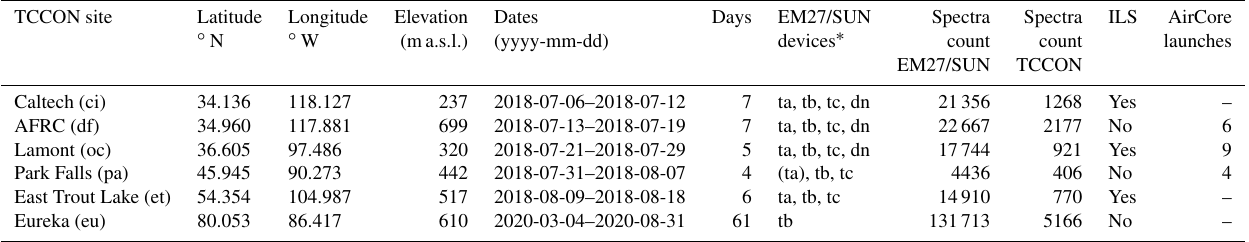
Table 1. This table lists the TCCON site locations and the dates that the EM27/SUN devices were on site, the number of days with successful measurements, the average number of spectra collected by each EM27/SUN, and the total number of spectra collected by the TCCON instrument during the visit. The instrumental line shape (ILS) column indicates whether EM27/SUN ILS measurements were collected at that location. The number of AirCore launches performed near the TCCON station during the dates listed is included in the final column. TCCON site